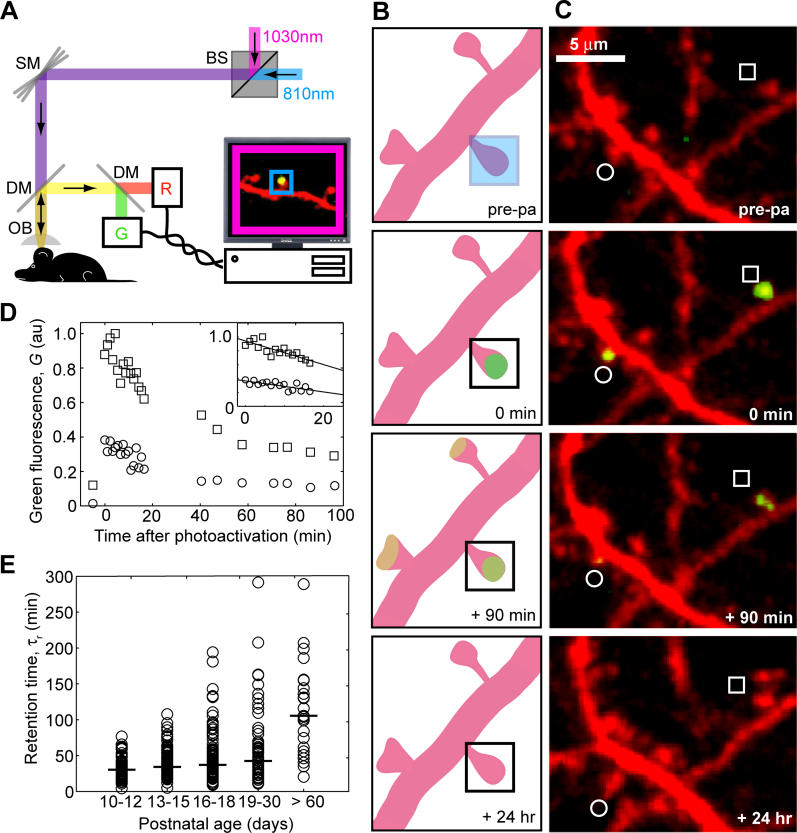
Rapid Turnover of PSD-95 in Individual PSDs(A) Schematic of the experimental setup. One laser (λ ~ 1,030 nm, magenta) was used to excite mCherry and photoactivated paGFP (paGFP*). A second laser (λ ~ 810 nm, blue) was used for photoactivation within a region of interest (blue box) within the field of view (magenta box). BS, beam-splitting cube; DM, dichroic mirror; OB, objective; R, G, photomultiplier tubes; SM, scan mirror.(B) Schematic of the experiment. Spines were selected for photoactivation (pre-pa, blue box), followed by time-lapse imaging.(C) Images collected before, and after (0 min, 90 min, and 24 h) photoactivation of two spines on different dendrites (age, P17).(D) Time course of PSD-95-paGFP* fluorescence (same as in [C]). The initial portion of the decay (inset) was used to extract the retention time (τ
r) of PSD-95-paGFP*.(E) Retention times. Circles represent single spines and the horizontal bars indicate the medians (τ
median). (P10–P12: τ
median = 30 min, range 4–77 min, n = 6 animals, 74 spines; P13–P15: τ
median = 34 min, range 5–108 min, n = 6 animals, 108 spines; P16–P18: τ
median = 37 min, range 9–194 min, n = 8 animals, 95 spines; P19–P30: τ
median = 43 min, range 11–291 min, n = 8 animals, 59 spines; >P60: τ
median = 106 min, range 20–289 min, n = 4 animals, 25 spines).